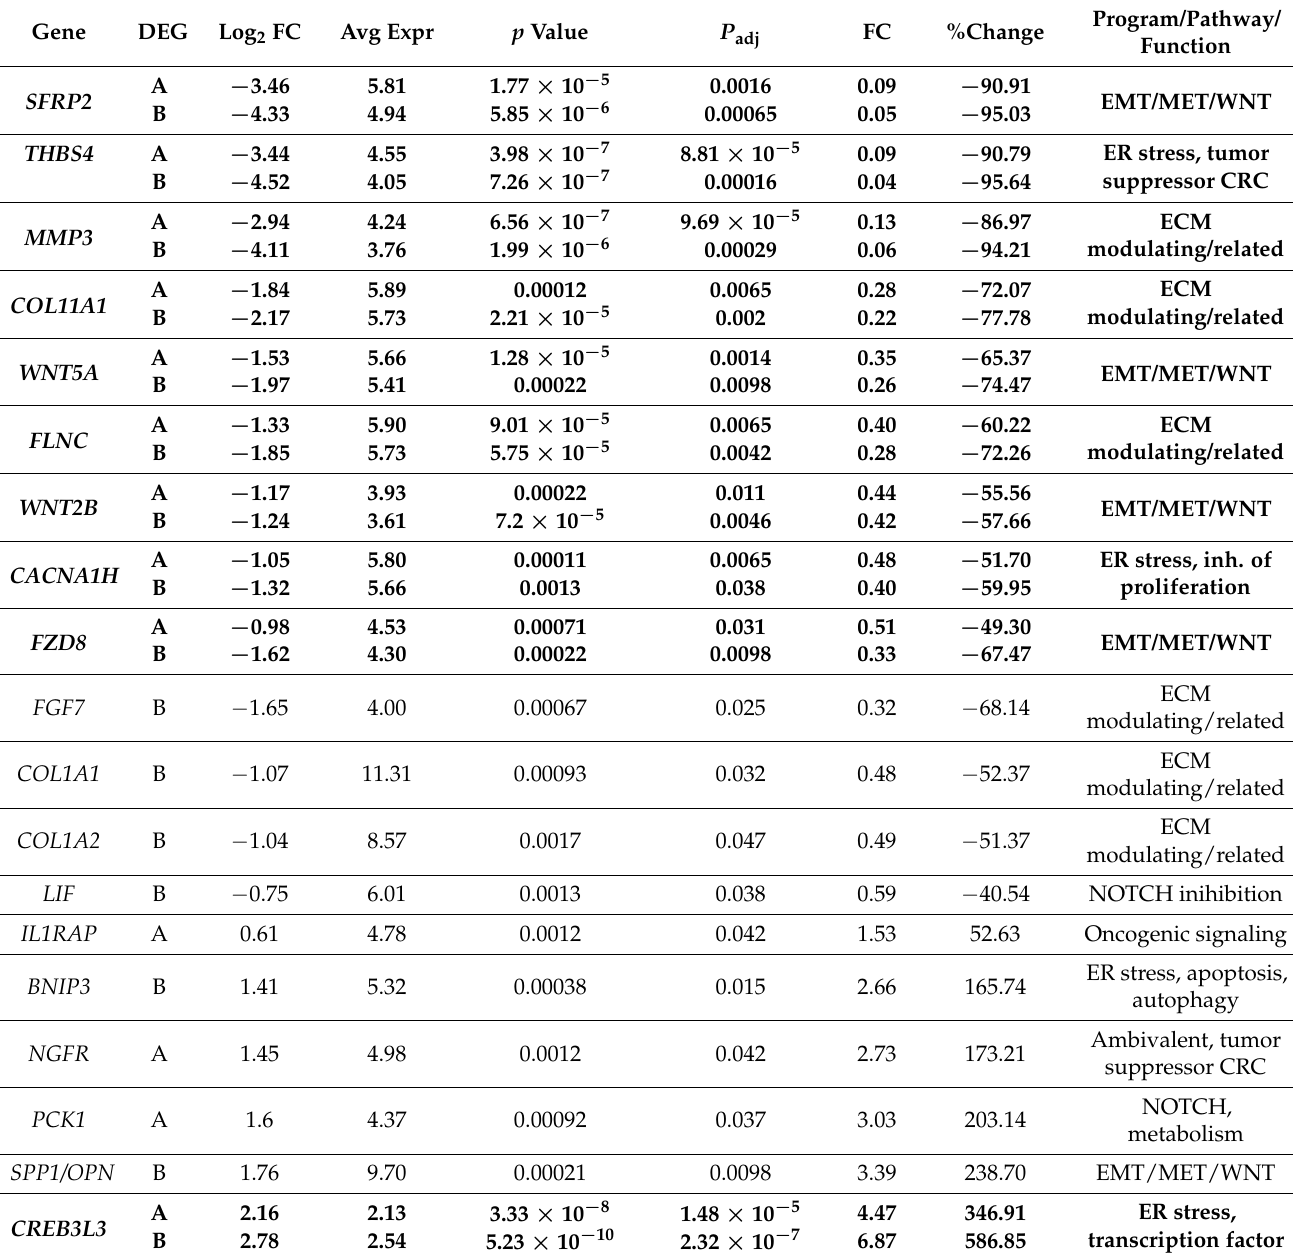
Table 2. Significant DEGs identified in all samples (DEG A) and paired samples (DEG